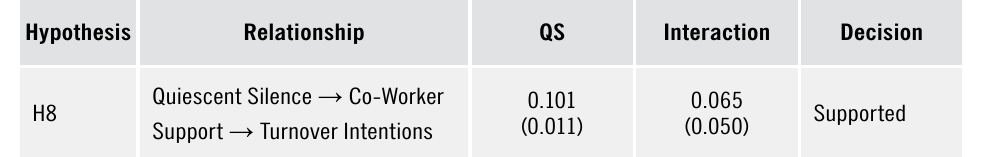
Table 6. Moderation effect of Co-worker Support